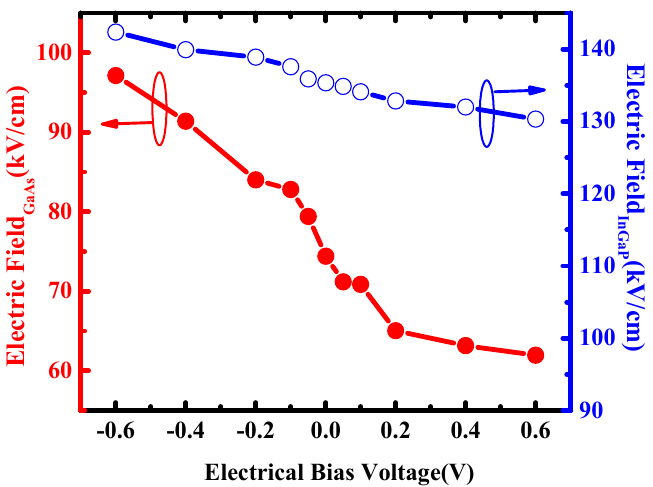
Figure 5. The internal electric field (F pn ) of InGaP (open circle) and GaAs (solid circle) versus electrical DC bias voltage at 300 K.